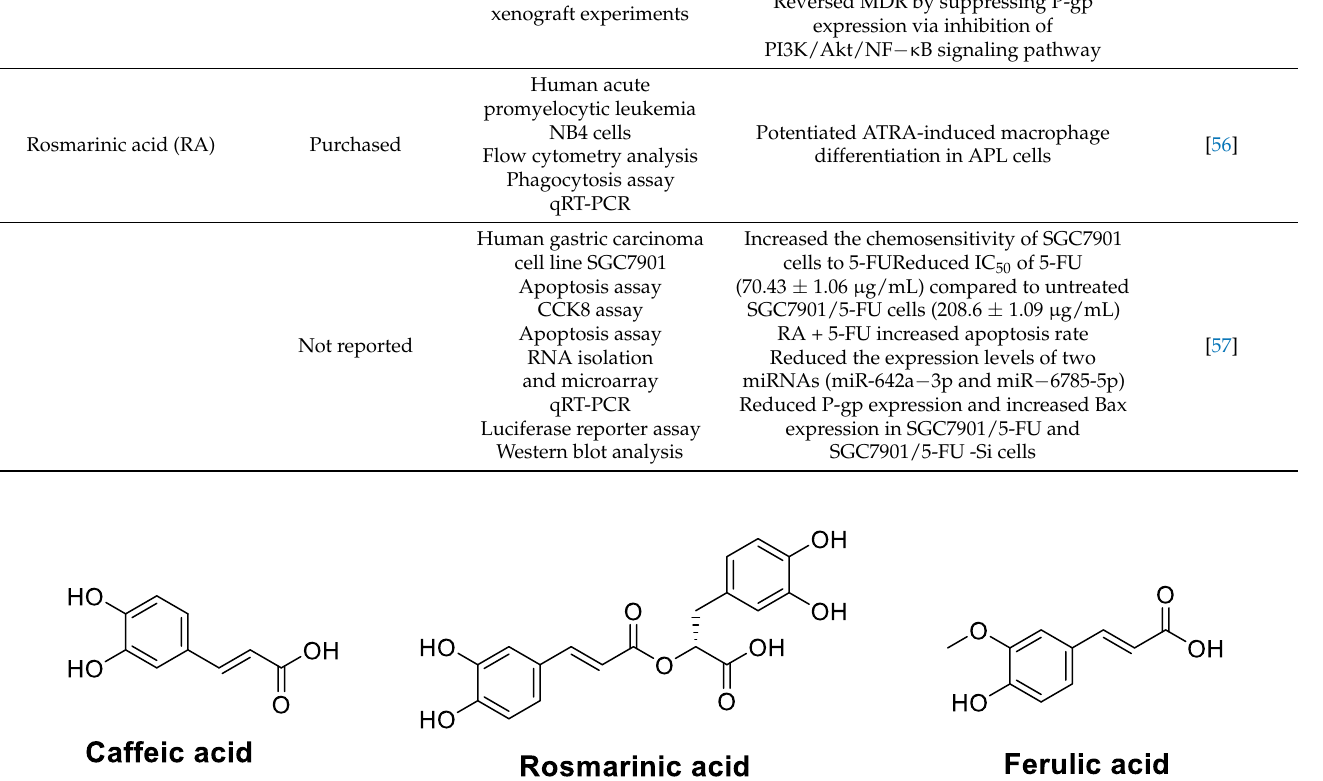
Figure 5. Chemical structures of phenolic acids that improve the chemosensitivity of anticancer